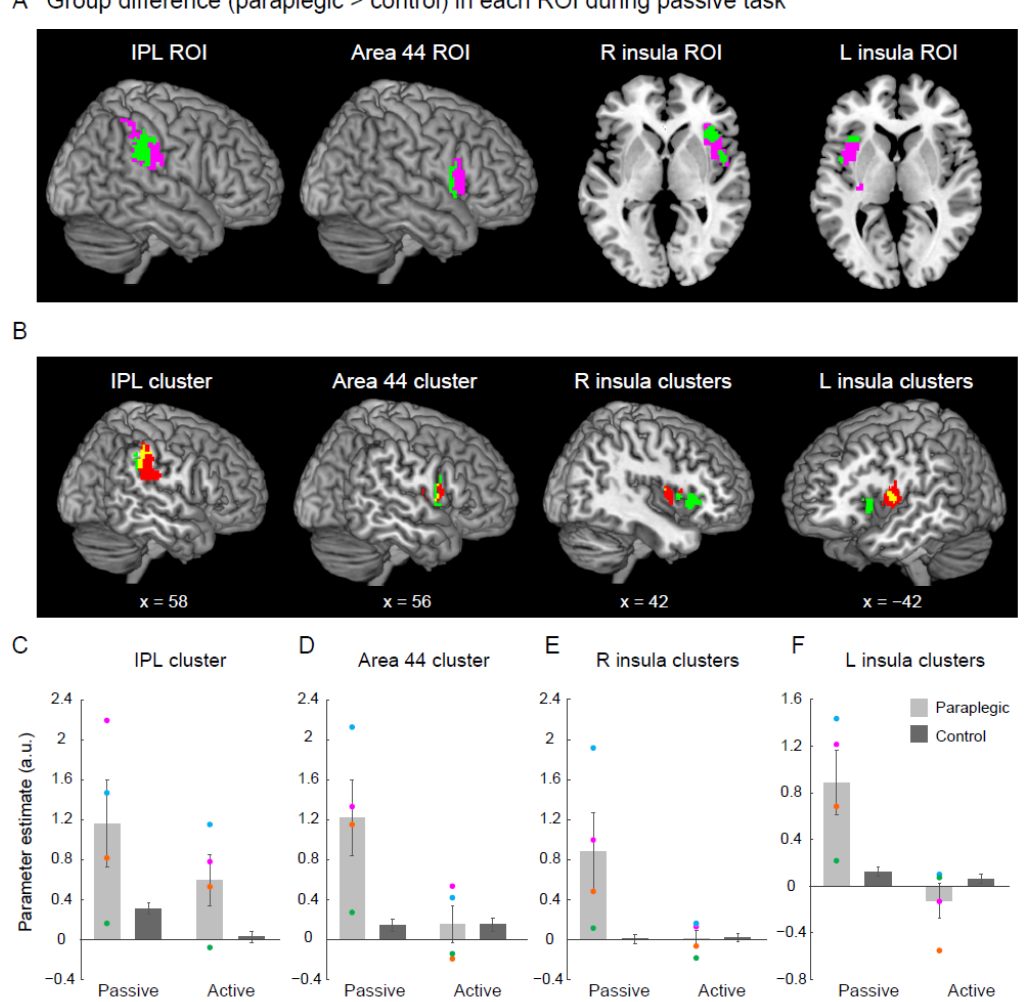
Figure 4. Results from the ROI analysis for the higher-order proprioceptive network. ( A ) Significant cluster(s) in which the paraplegic group showed greater activity during the passive task than the control group (green section) within the IPL, area 44, R insula, and L insula ROIs (pink sections). The clusters and the ROIs are superimposed on the MNI brain. ( B ) The significant clusters identified in each ROI (green sections) and the brain regions active during the passive task in the control group (red sections) are superimposed on the MNI brain. Yellow sections indicated the overlapping areas of the two sections. ( C – F ) Bar graphs show the mean value of brain activity (parameter estimate) obtained from the identified cluster(s) in each ROI across participants for each task in both paraplegic group (light gray) and control group (dark gray). Individual data from the paraplegic group are also plotted (pink, green, orange, and blue circles represent the data obtained from P1, P2, P3, and P4, respectively). Lines on the bars indicate standard errors of the mean across participants. Abbreviations: a.u., arbitrary unit; R, right; L, left; IPL, inferior parietal lobule; IFG, inferior frontal gyrus; MNI, Montreal Neurological Institute; ROI, region of interest.